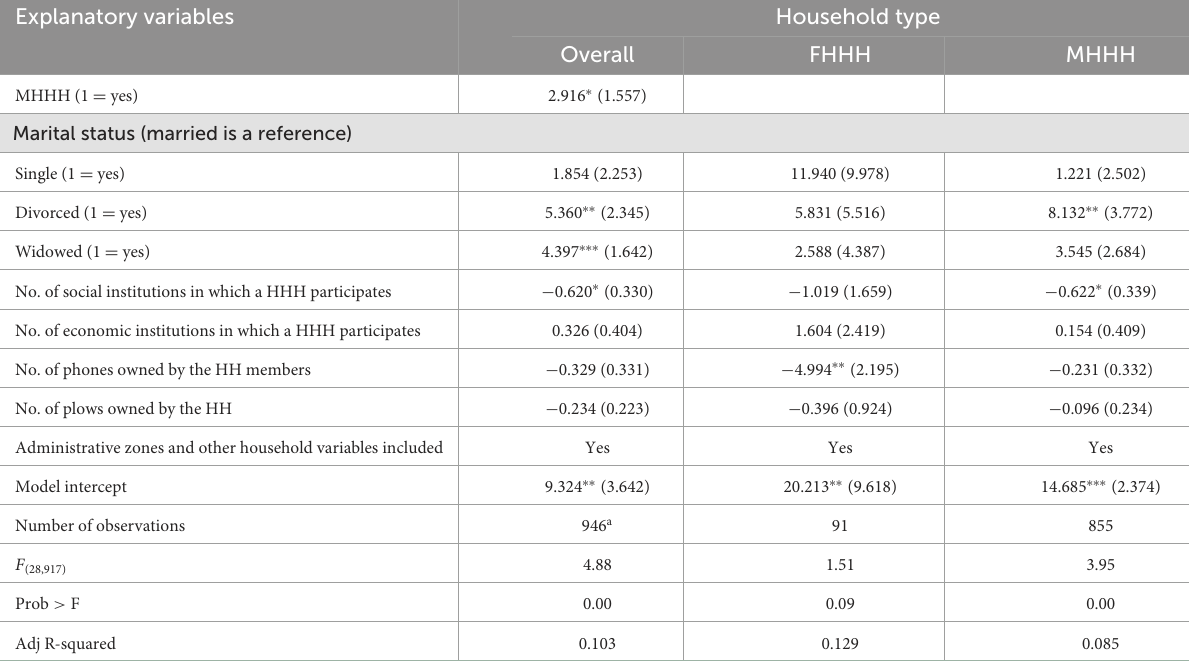
TABLE 8 Determinants of age of wheat varieties grown (OLS). Explanatory